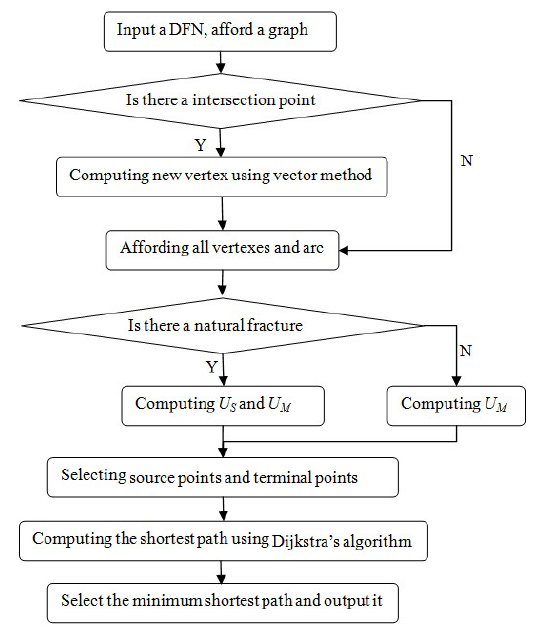
Figure 8. The flow chart of the completed algorithm.